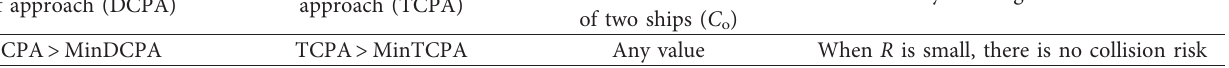
Table 1: Process of early warning method of inland ship collision risk based on coordinated collision-avoidance actions. Distance to the closest point